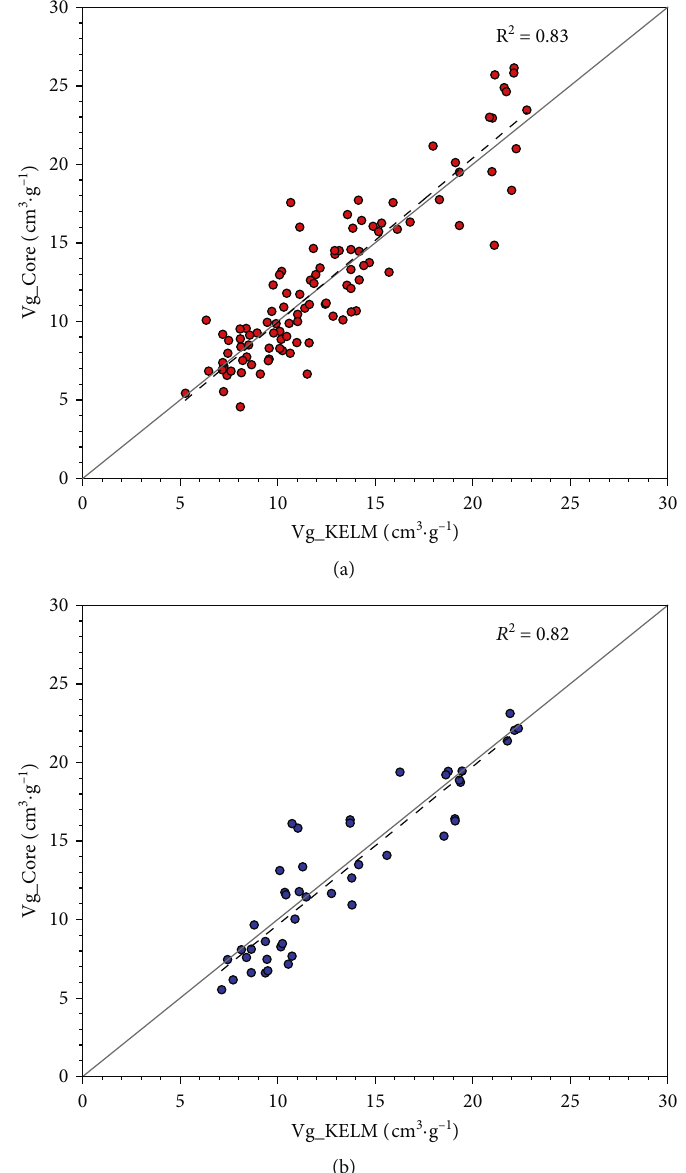
Figure 15: Application e ff ect of CBM content model constructed by KELM method: (a) application e ff ect of training dataset; (b) application e ff ect of test